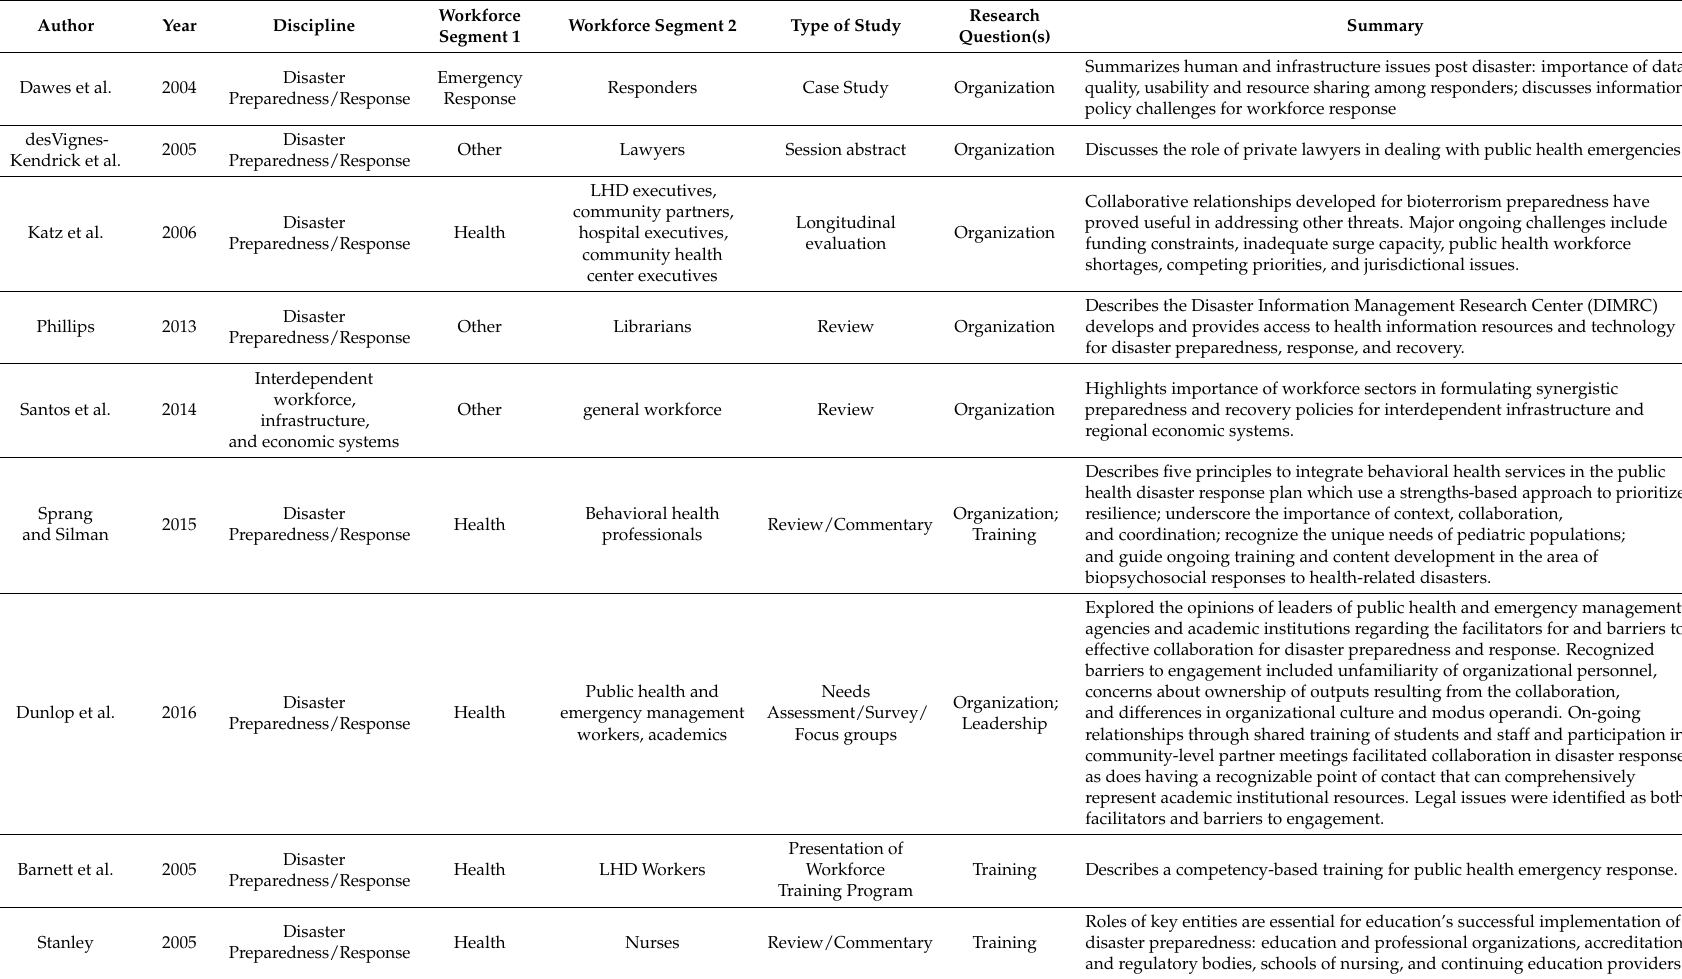
Table 1. Resilience-oriented workforce